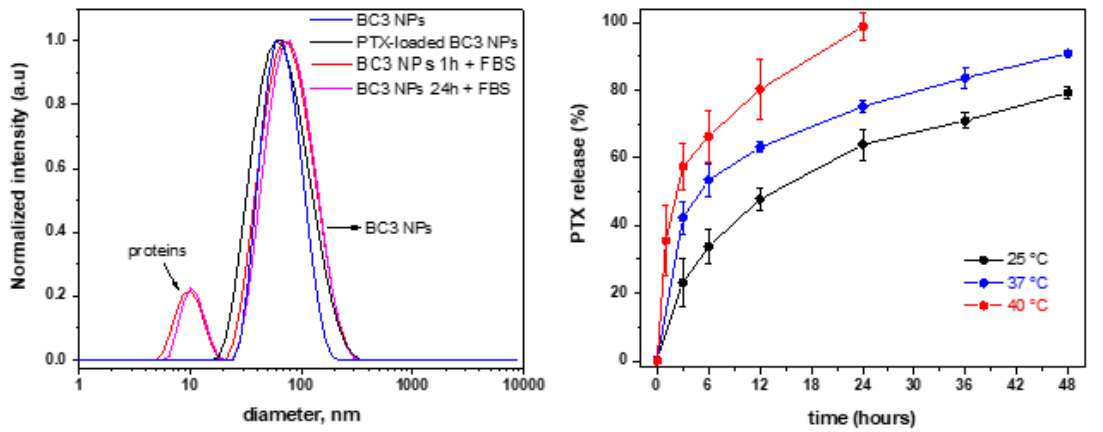
Figure 12. Size distributions obtained by DLS for PTX-unloaded BC3 NPs (blue lines), PTX-loaded BC3 NPs (black lines), and in the presence of 10% FBS after 1 h (red lines) and 24 h (magenta lines) ( left ), in addition to drug release profiles from PTX-loaded BC3 at 25 (black lines), 37 (blue lines), and 40 °C (red lines) ( right ).